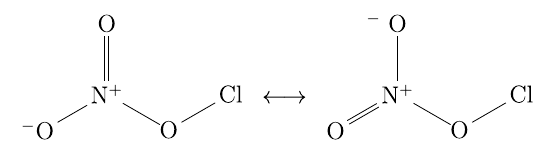
Figure 1. The chemical structure of chlorine nitrate.